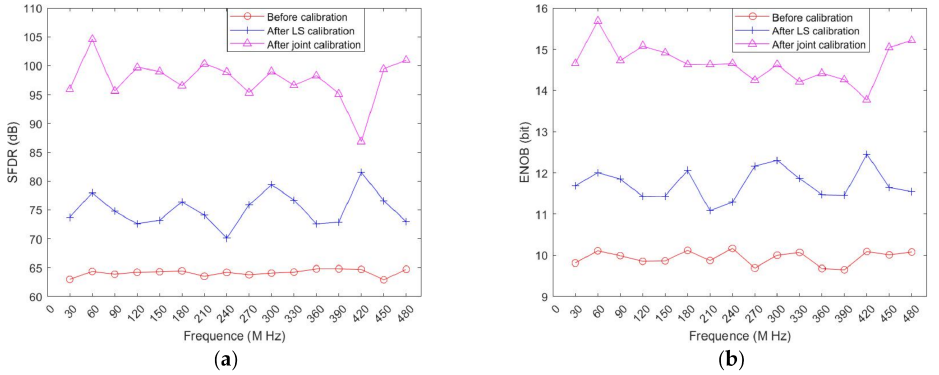
Figure 12. ( a ) SFDR of different stages; ( b ) ENOB of different